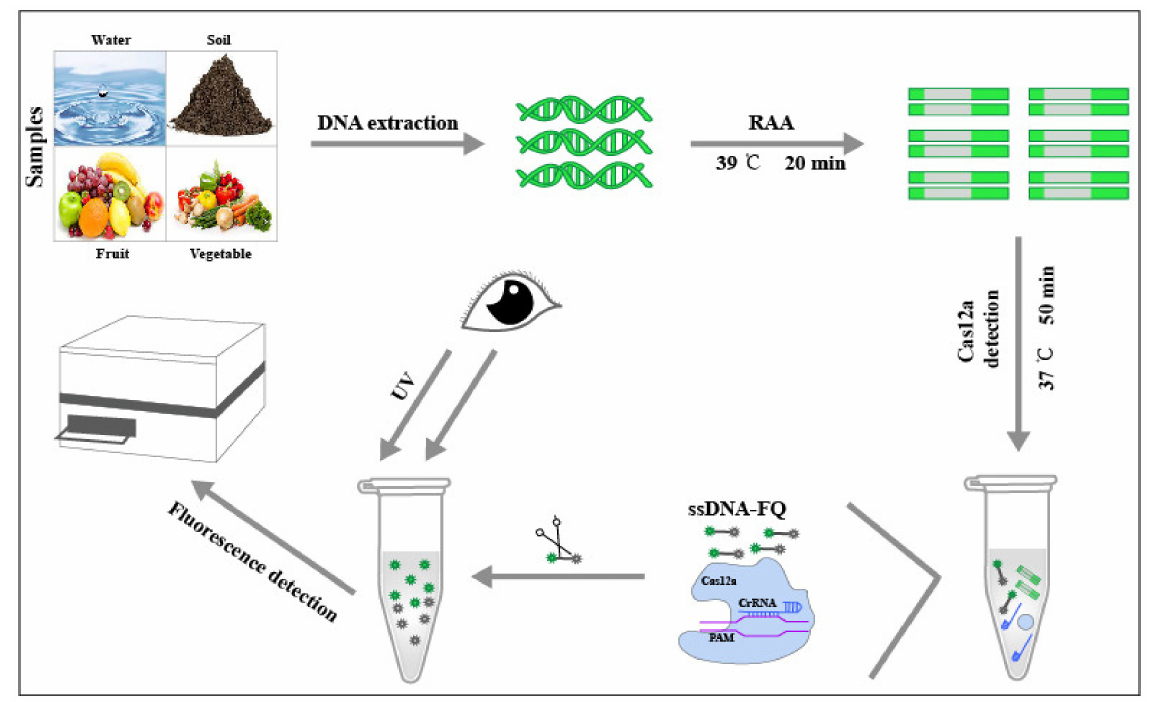
Figure 1. Schematic diagram of the application of the RAA-Cas12a-Tg detection system to environmental samples such as soil, water, fruit and